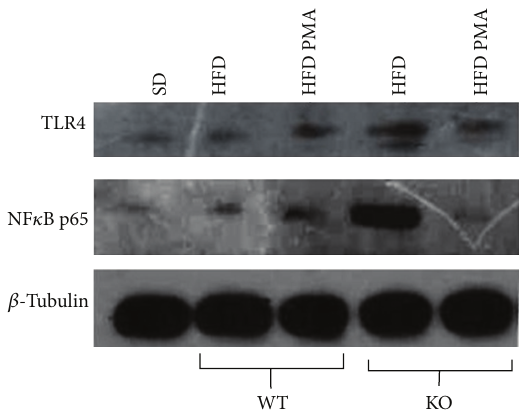
Figure 7: Protein levels of Toll-like receptor-4 (TLR-4) and serine phosphorylation of NF Κ B p65 in the liver of WT mice fed with a standard diet (SD) or WT and PPAR 𝛼 -knockout (KO) mice fed with high-fat diet and treated with oleic acid (HFD) or palmitoleic acid (HFD